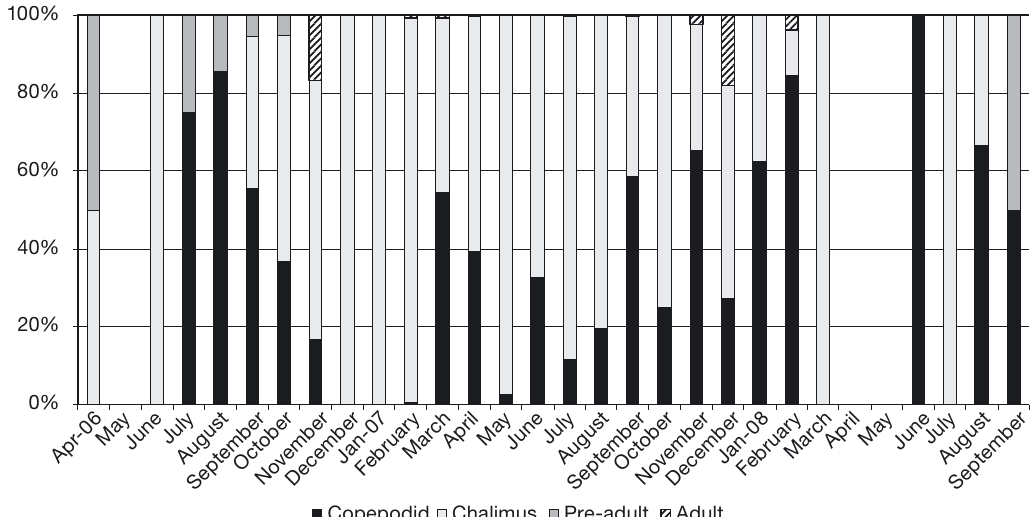
Fig. 2. Monthly breakdown of life cycle stages of sea lice on the sentinel fish from April 2006 to September 2008